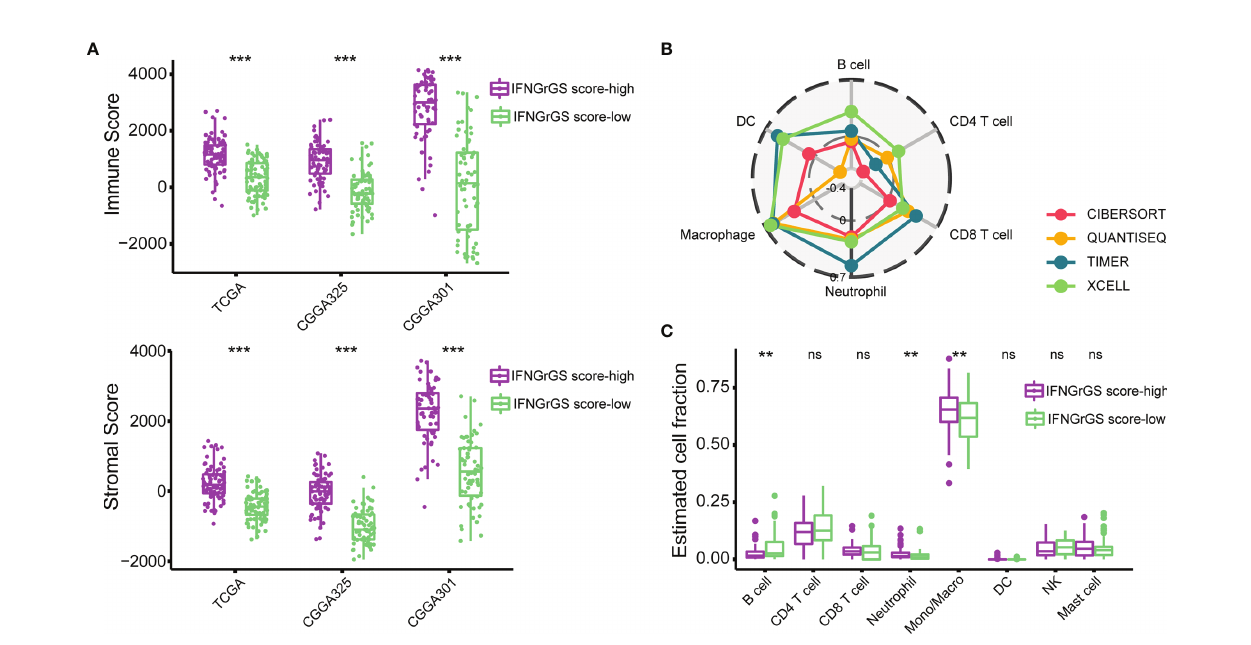
FIGURE 2 | Exploration of the immune in fi ltration characteristics associated with the IFNGrGS-based strati fi cation. (A) The immune-score and stromal-score between the IFNGrGS score-high and -low groups using the ‘ ESTIMATE ’ algorithm. (B) Correlation analysis of the IFNGrGS score and immune in fi ltrations based on the TCGA cohort. 4 independent in silico methods were employed. The correlation coef fi cient increases from the center (-0.4) to the periphery (0.7), and the grey circle in the middle indicates a correlation coef fi cient of 0. (C) Immune in fi ltration between the IFNGrGS score-high and -low groups estimated by CIBERSORT based on the TCGA cohort. **p < 0.01, ***p < 0.001, and ns, non-signi fi